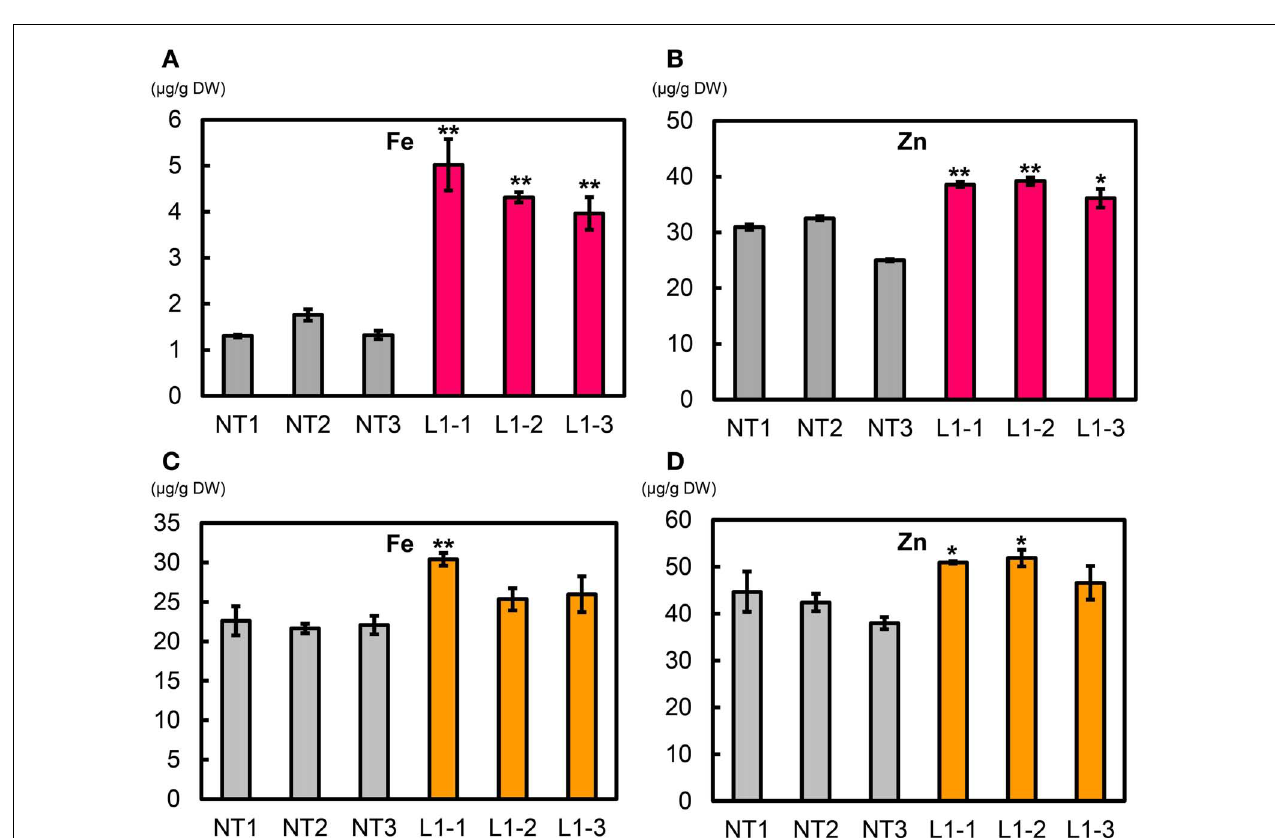
L1-2, and L1-3, Paw SanYin-Fer-NAS-YSL2 transgenic line 1 sublines. Bars represent means ± SE, n = 3. Asterisks ( * ) and ( ** ) above the bars indicate significant differences at P < 0.05 and P < 0.01, respectively, between NT and L1 sublines demonstrated by t